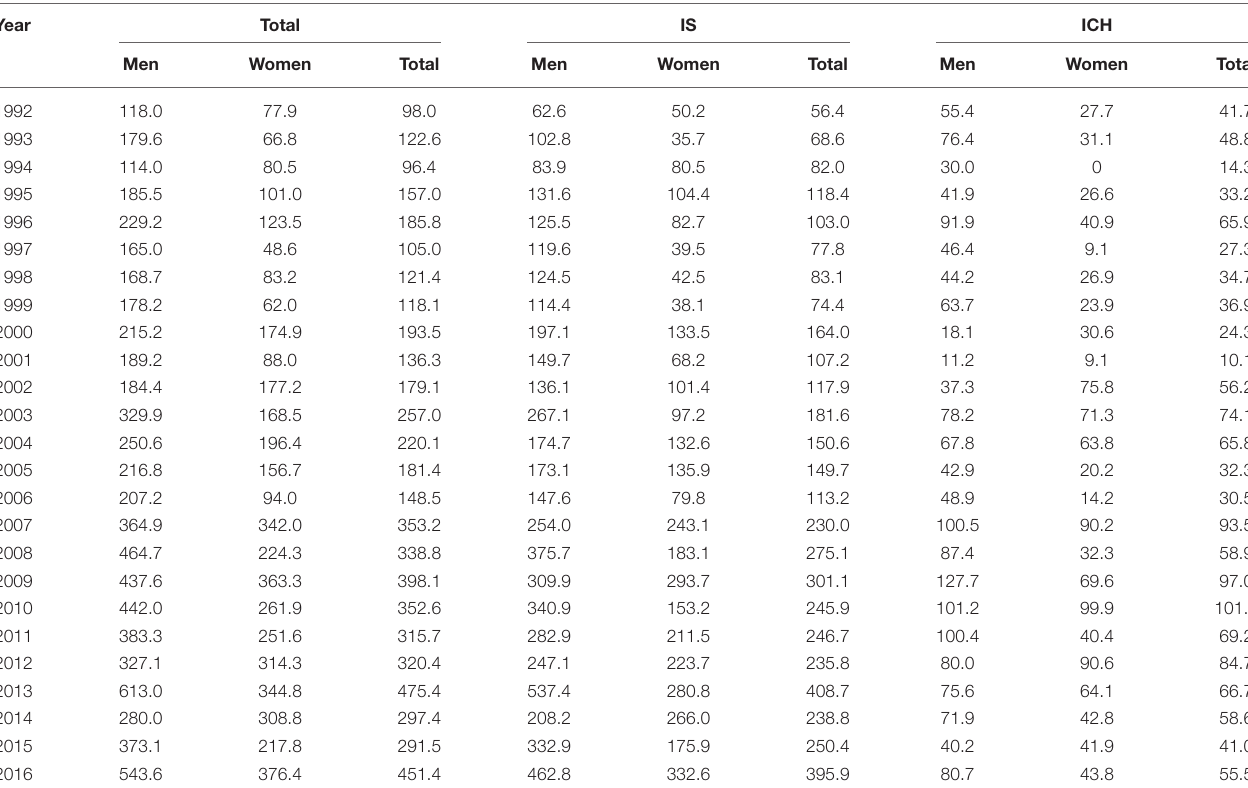
TABLE 2 | The age-standardized incidence of stroke in study population during 1992 to 2016 by sex and type. Year Total IS ICH Men Women